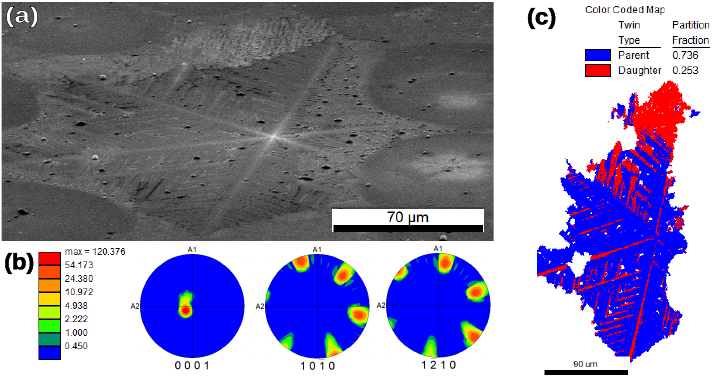
Figure 6. EBSD analysis of the x = 5% sample. Indexing is made with the α -quartz unit cell. ( a ) 71 ◦ - tilted SEM image of one of the dendrites. ( b ) Orientation distribution function (ODF) plotted for three different poles in multiple of random distribution (MRD) scale indicates a single crystal with [c] direction almost perpendicular to the sample surface (A3 axis). ( c ) EBSD map of the dendrite from ( a ), whose lateral size is a few hundred micrometers. Map demonstrates the presence of two Dauphiné twin-related orientations inside the dendrite. No other grain boundaries (>3 ◦ misorientation between neighboring pixels) are present.